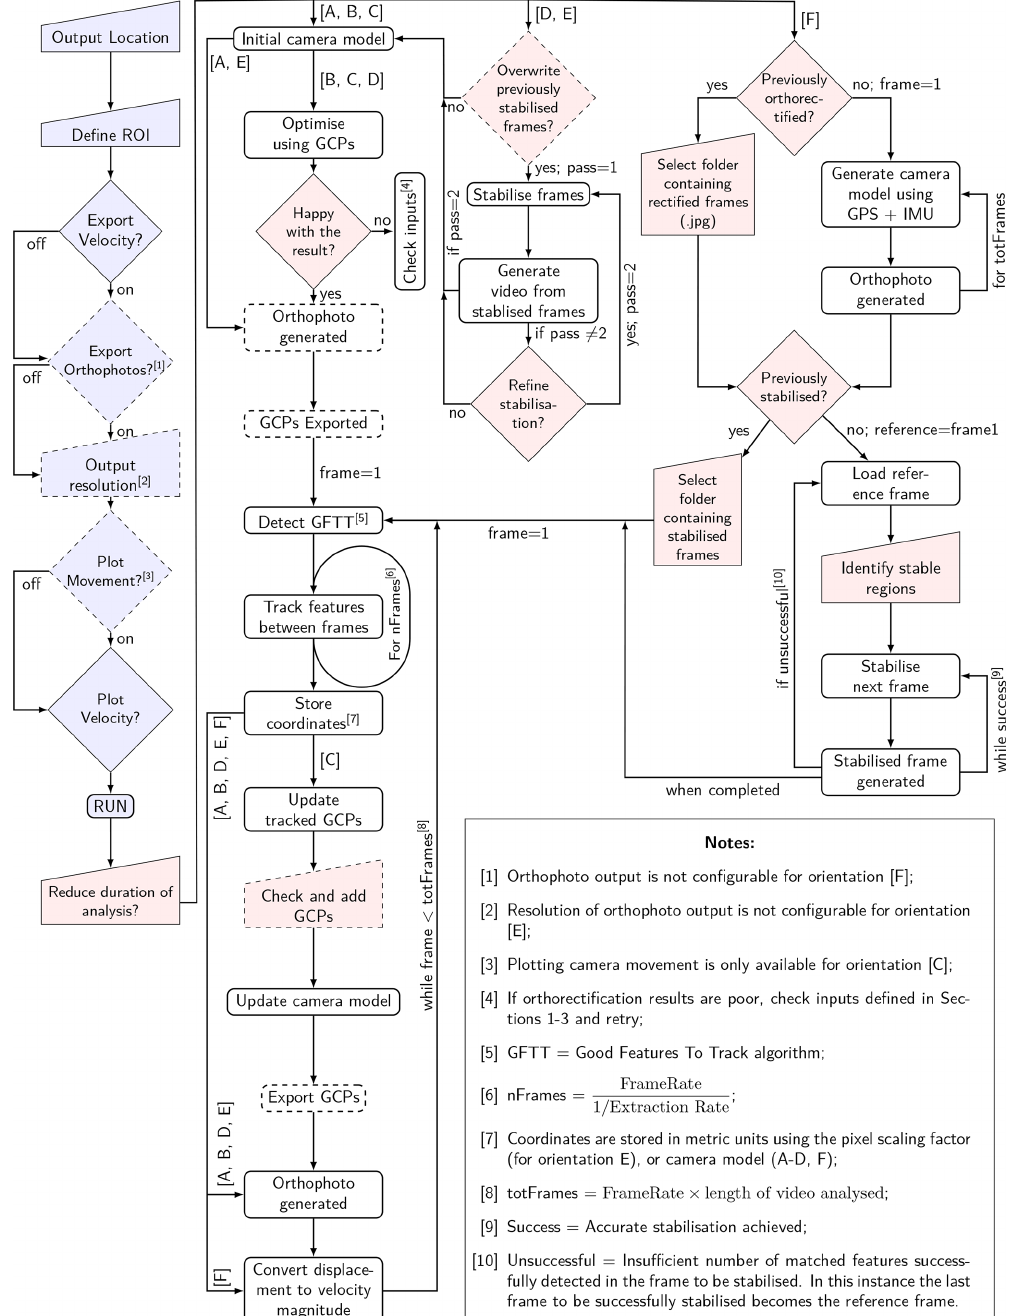
Figure 3. Workflow for Sect. 4 of KLT-IV (shown in blue) and an outline of the image processing routine used in the determination of velocity magnitudes. Capitalised letters in square brackets correspond to the orientation defined in Table 1. Dashed icons represent optional inputs/outputs, which are dependent on the settings provided in Sect. 1–4. Red icons represent user inputs which are prompted once the “RUN” button has been